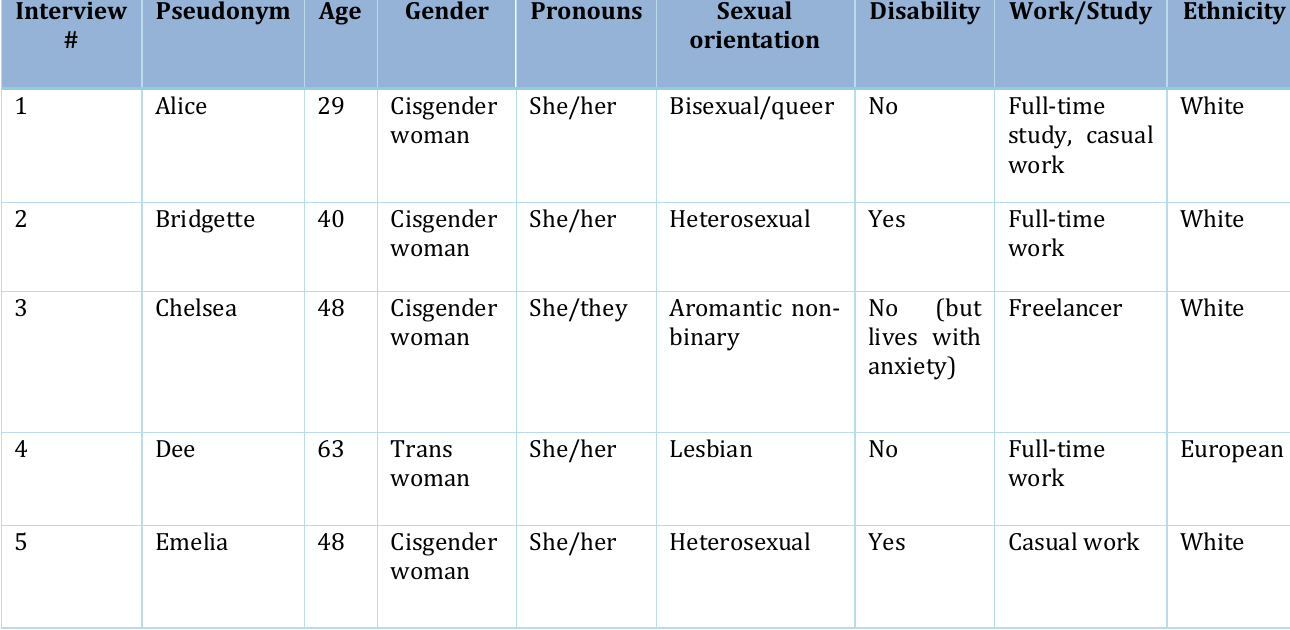
Table 2: Demographic characteristics of the interview sample